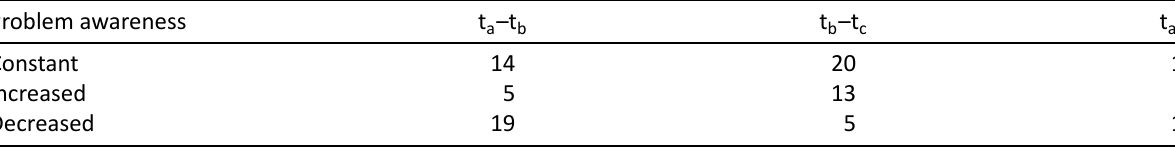
Table 4. Changes in problem awareness in absolute numbers of participants. Problem